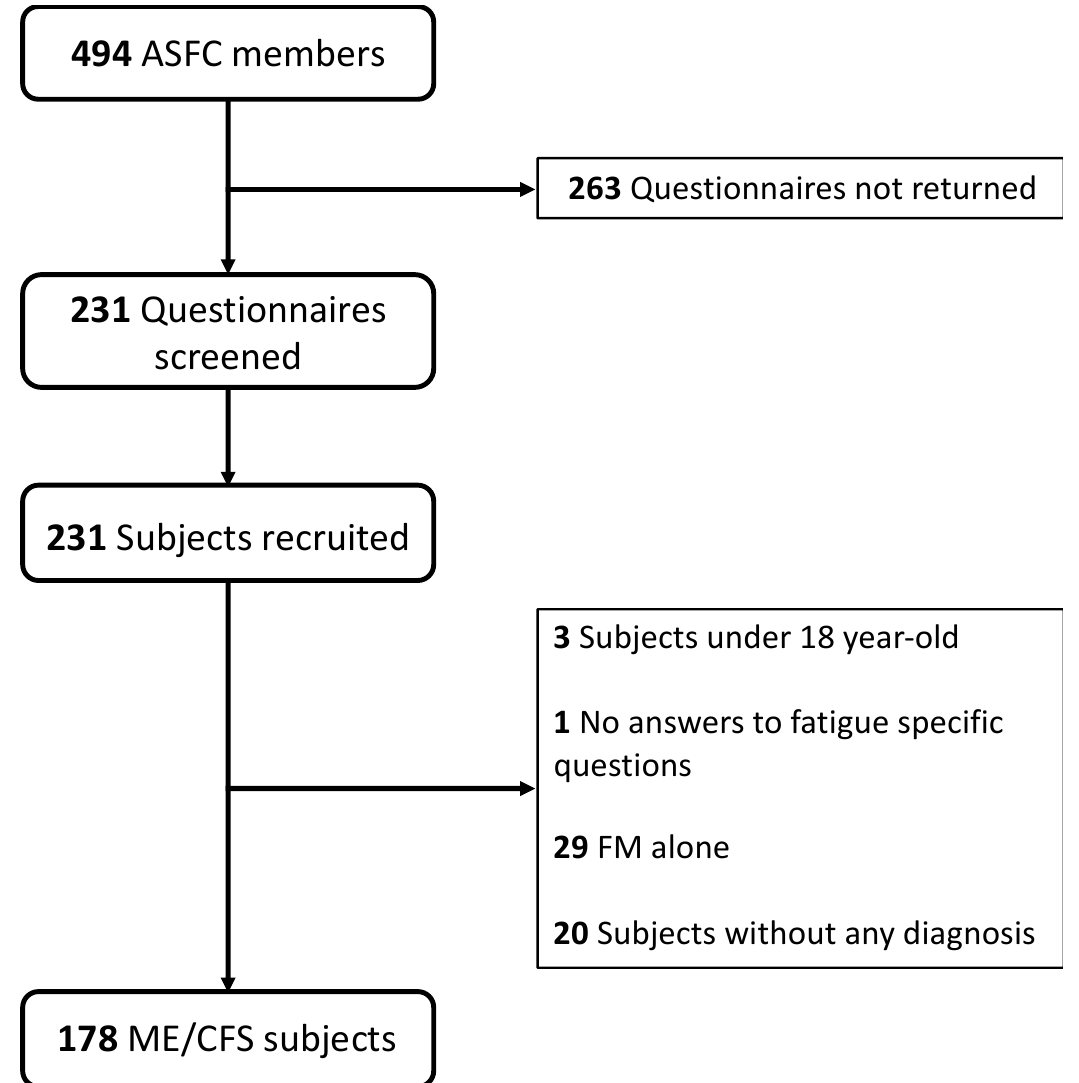
Figure 1. Study flowchart: from the 494 members of ASFC, 231 patients were recruited and after selection, 178 were included as they suffered from ME/CFS.